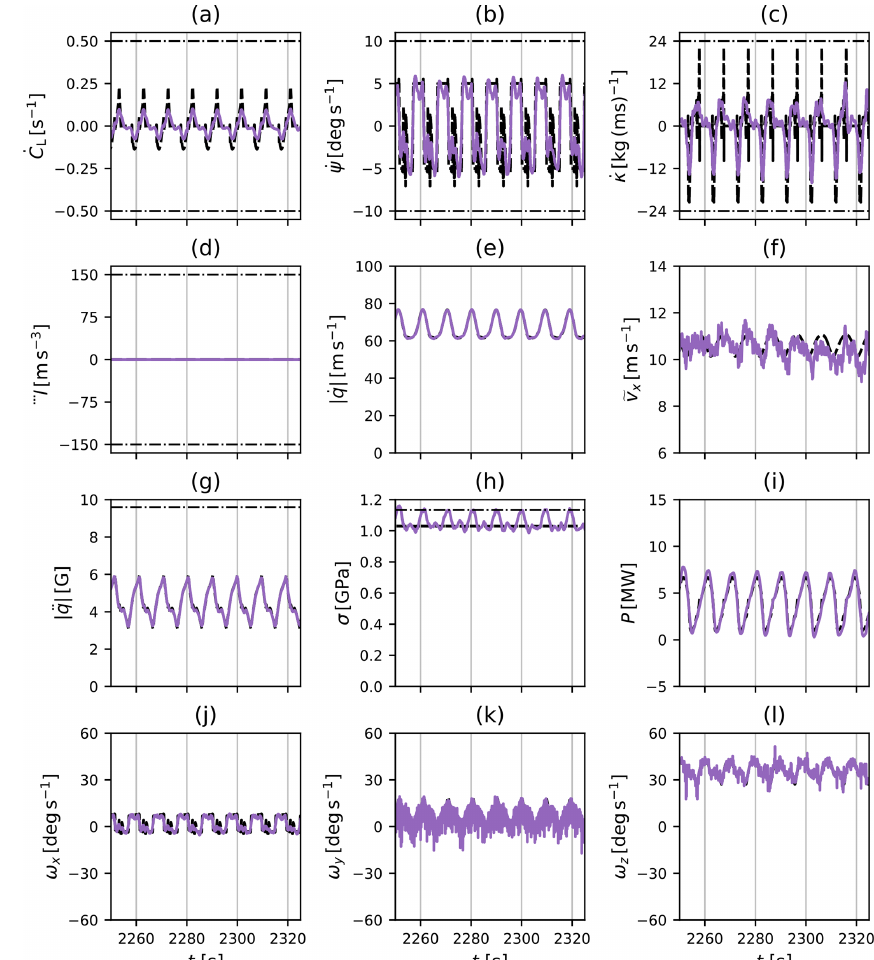
Figure B8. Instantaneous controls and additional quantities measured at the point mass of the drag-mode AWE system 003 (park D1) compared to their reference values. The control variables, i.e. the time derivatives of lift coefficient ˙ C L , roll angle ˙ (cid:57) , and thrust coefficient ˙ κ , ... l are shown in (a–d) . The magnitude of the flight speed |˙ q | and the streamwise wind speed (cid:101) v x are shown in (e) and (f) . and the tether jerk The magnitude of acceleration |¨ q | , the tether stress σ , and the instantaneous power P are respectively shown in (h, i) . The components of the angular velocity ω are shown in (j–l) . The black dashed and dashed–dotted lines respectively represent the variable references and the eventual constraints applied to the variables in NMPC (Eq.